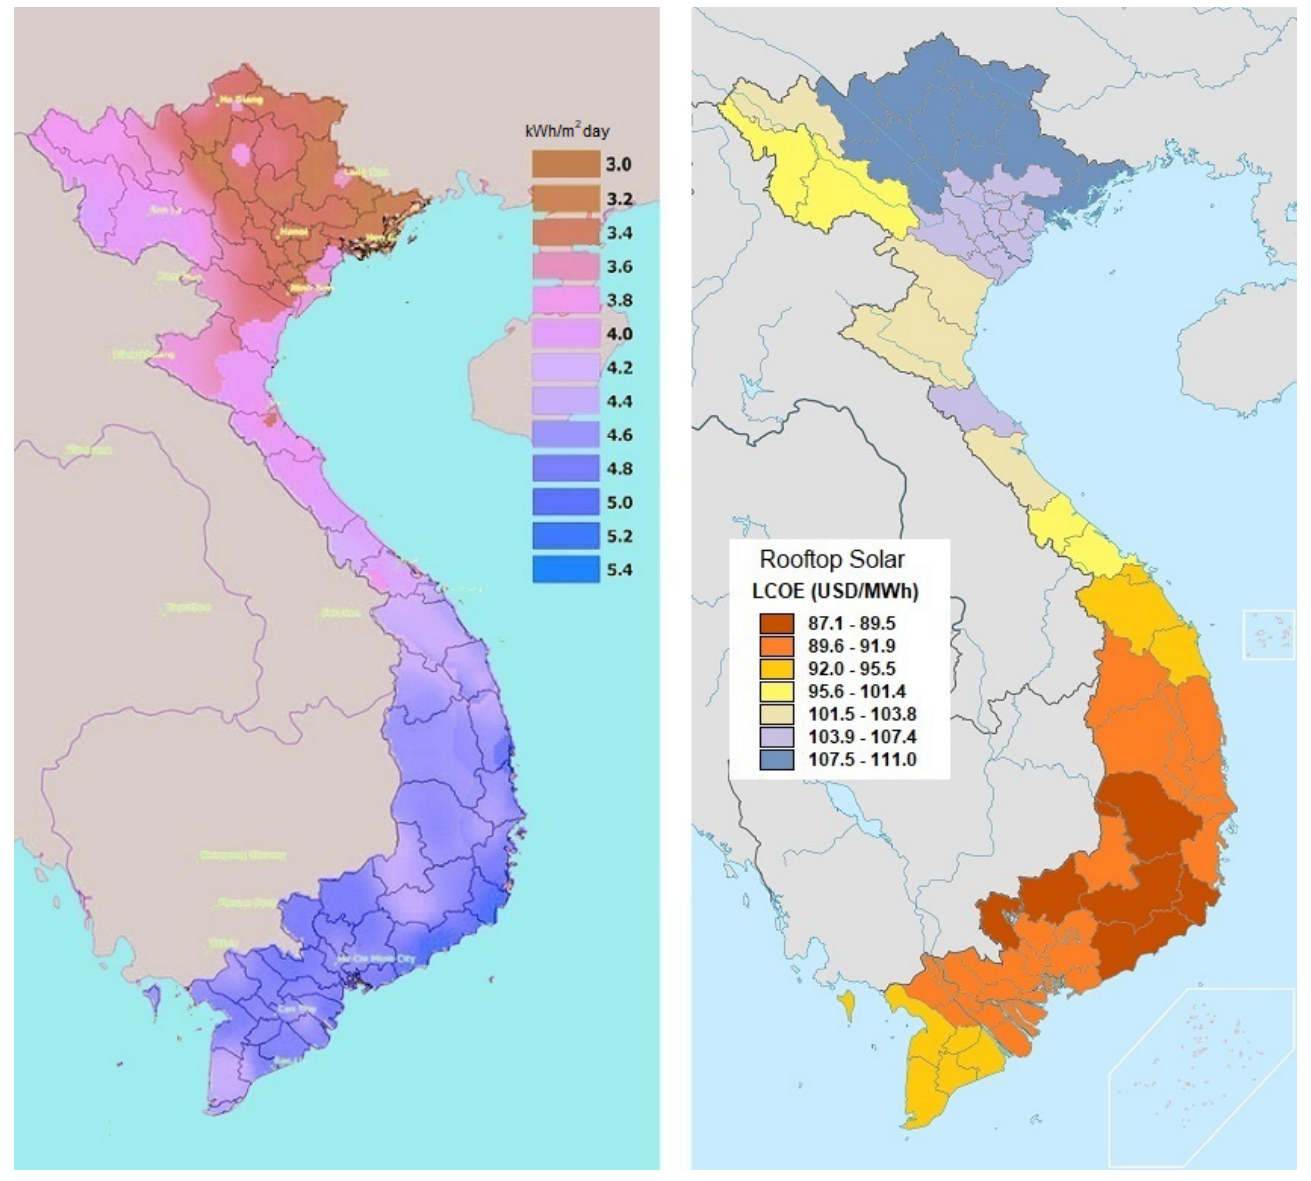
Figure 13. Solar potential and LCOE for RTS in Vietnam in 2019–2020. Reprinted with permission from Refs. [45,66]. Copyright 2020 Energies; Copyright 2015 Vietnam Ministry of Industry and Trade & Spanish Agency for International Development Cooperation.